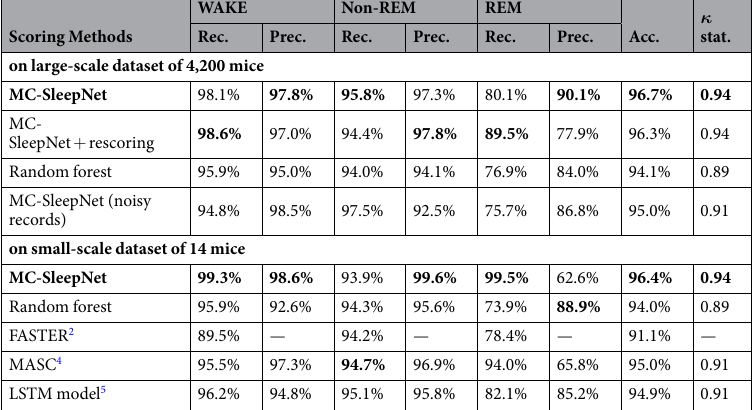
Table 1. Scoring performance on large-scale and small-scale